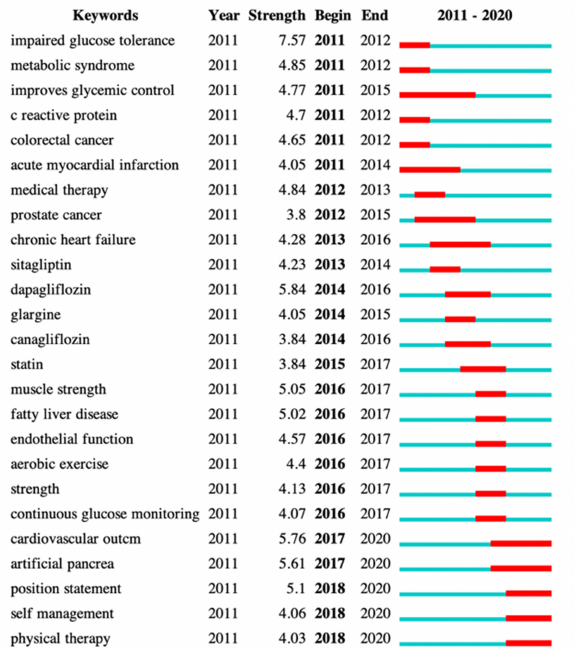
FIGURE 5 | The top 25 keywords with the strongest citation bursts in physical activity therapy for diabetes